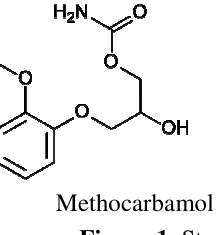
Figure 1. Structure of methocarbamol, paracetamol and diclofenac